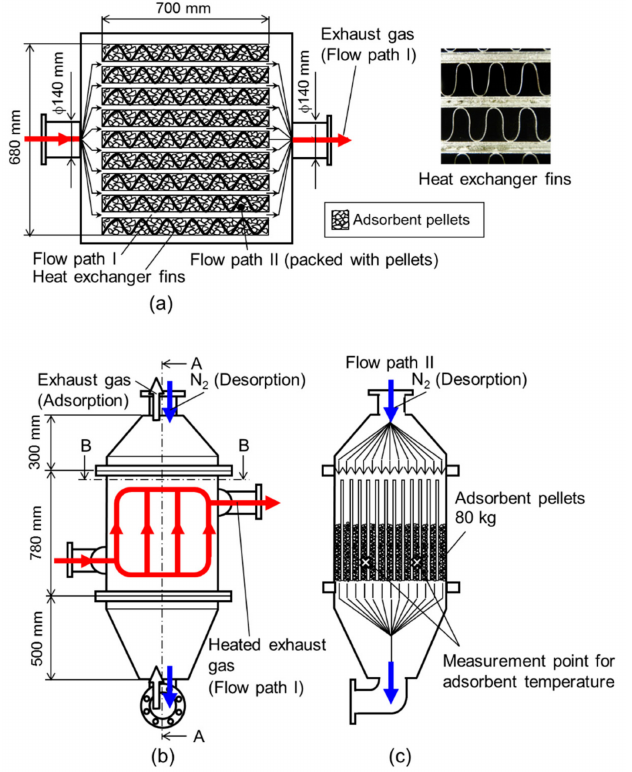
Figure 5. Schematic of the adsorption chamber containing 80 kg of adsorbents with gas flows in the desorption process. ( a ) Cross section B-B; ( b ) Side view; ( c ) Cross section